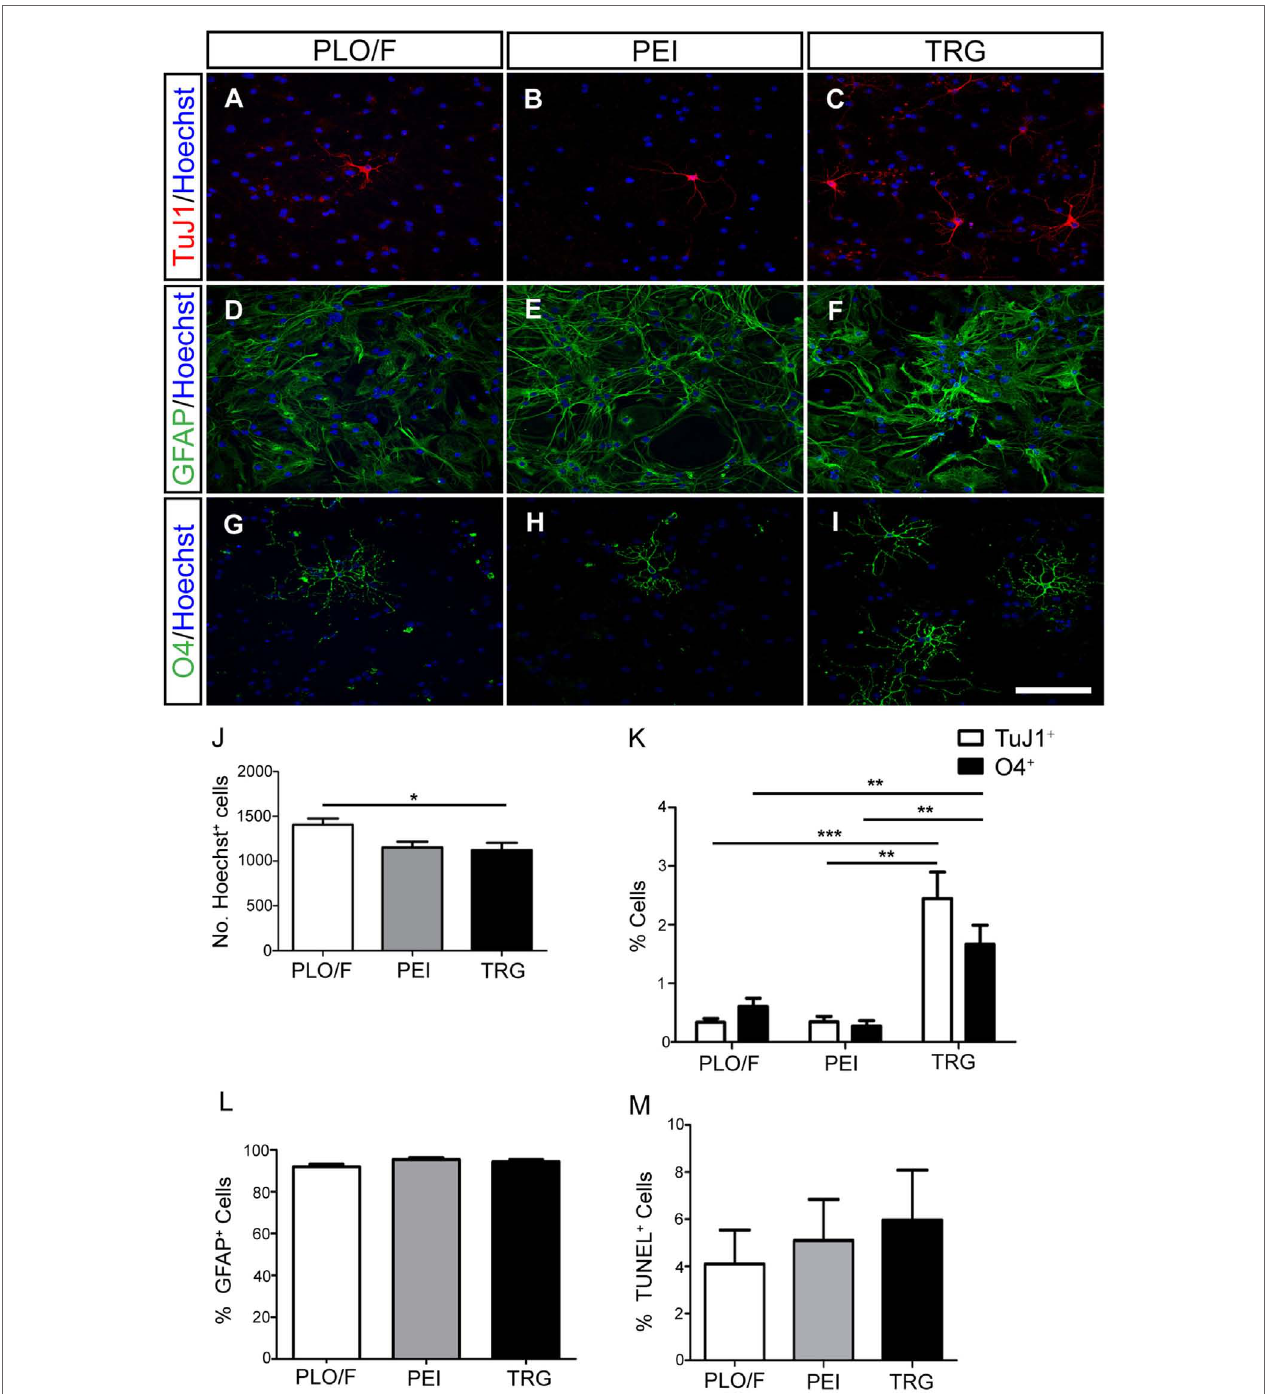
FigUre 4 | effect of Trg on the long-term survival of neurons, astrocytes and oligodendrocytes obtained from aOBscs . The aOBSC neurospheres were dissociated and seeded on PLO/F, PEI and TRG coverslips in serum-containing medium for 15–18 DIV. Neurons (a–c) , astrocytes (D–F) , and oligodendrocytes ( g–i) were detected using antibodies against β -III tubulin (TuJ1), GFAP, and O4. A small but yet significant 15.5% decrease was found in the number of Hoechst + cells grown on TRG and PEI coverslips compared to PLO/F (J) . There were 2- to 6-fold significant increases in the percentages of TuJ1 + cells and O4 + cells grown on TRG compared to PEI and PLO/F (K) . The majority of the cells in the cultures were GFAP + astrocytes, and the percentages of astrocytes were similar in the three conditions (l) . No significant differences were observed in the percentages of TUNEL + dead cells between conditions (M) . The graph bars represent the mean ± SEM ( n = 5–16 cultures per condition). Statistical analyses were performed using one-way ANOVA and Kruskal–Wallis tests together with Tukey’s and Dunn’s tests. * P < 0.05, ** P < 0.01, *** P < 0.001. Scale bar [shown in (i) ] = 100.5 μ